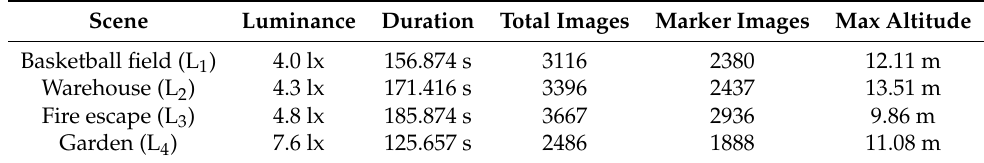
Figure 9. One of the recorded manual flight tests. ( a ) The three-dimensional plot of the quadrotor’s trajectory for mission phase determination. ( b ) The quadrotor’s local velocities of the x , y , and z axes. Table 1. Statistics of the collected videos in field